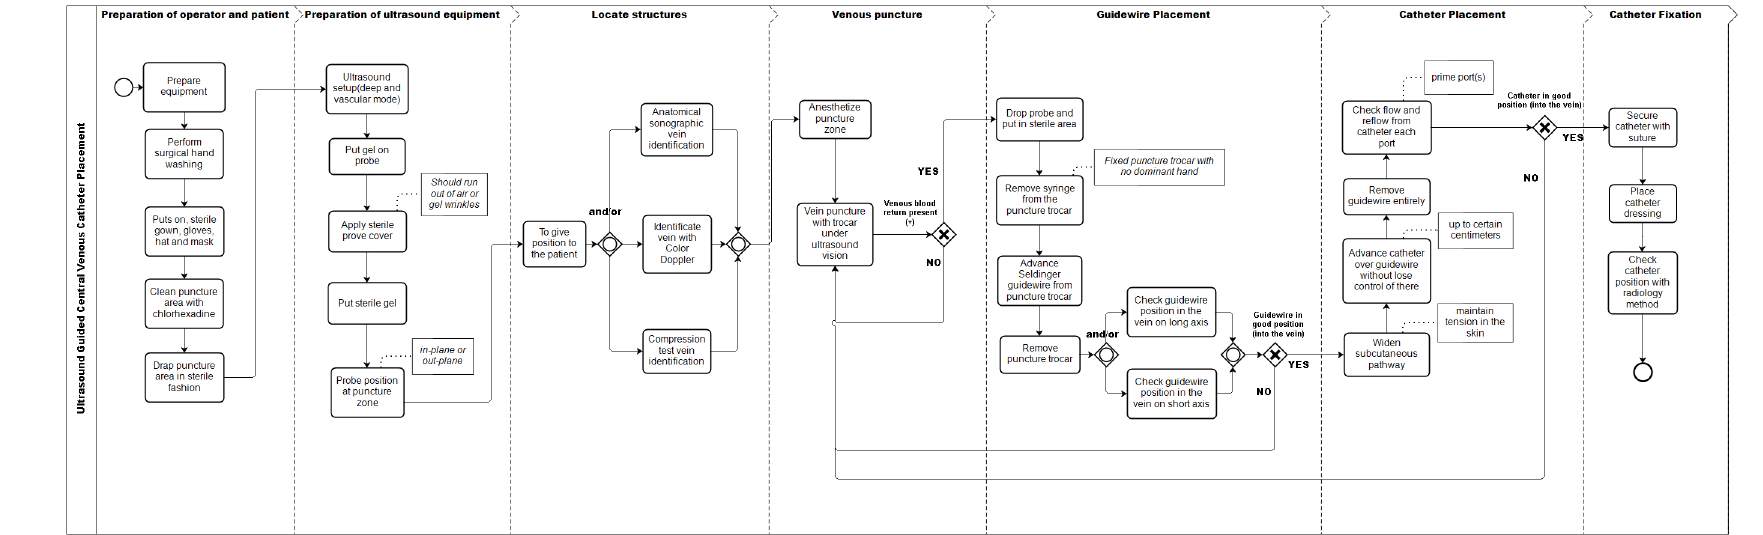
Figure 2. Process model of the central venous access placement with ultrasonography after delphi panel, represented in